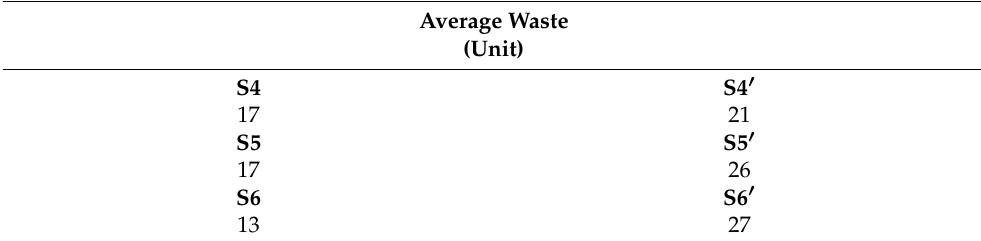
Table 6. Waste (i.e., defective units) under scenarios S4–S6 and S4 (cid:48) –S6 (cid:48) . Average